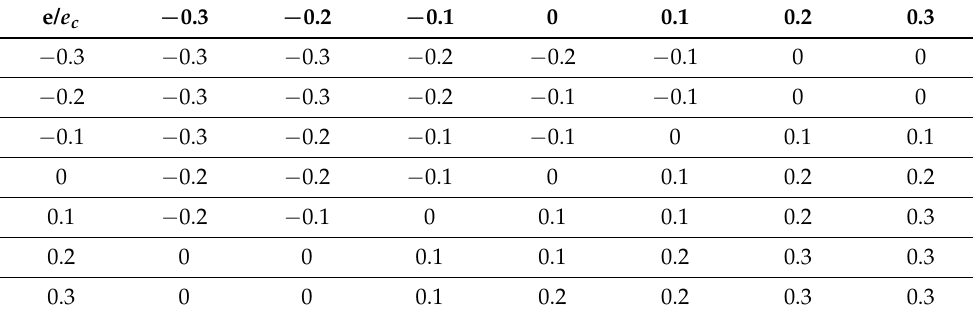
Table 7. K d seven-valued